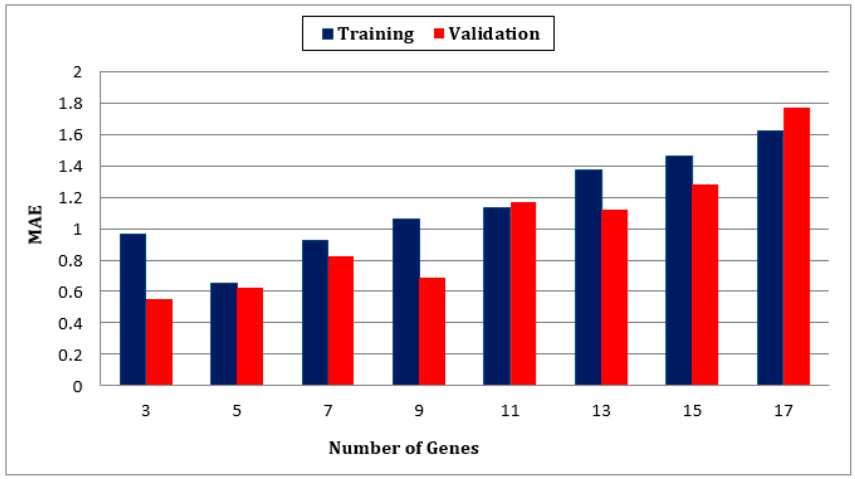
Figure 14. Comparison between MAE of training and validation for different numbers of genes.